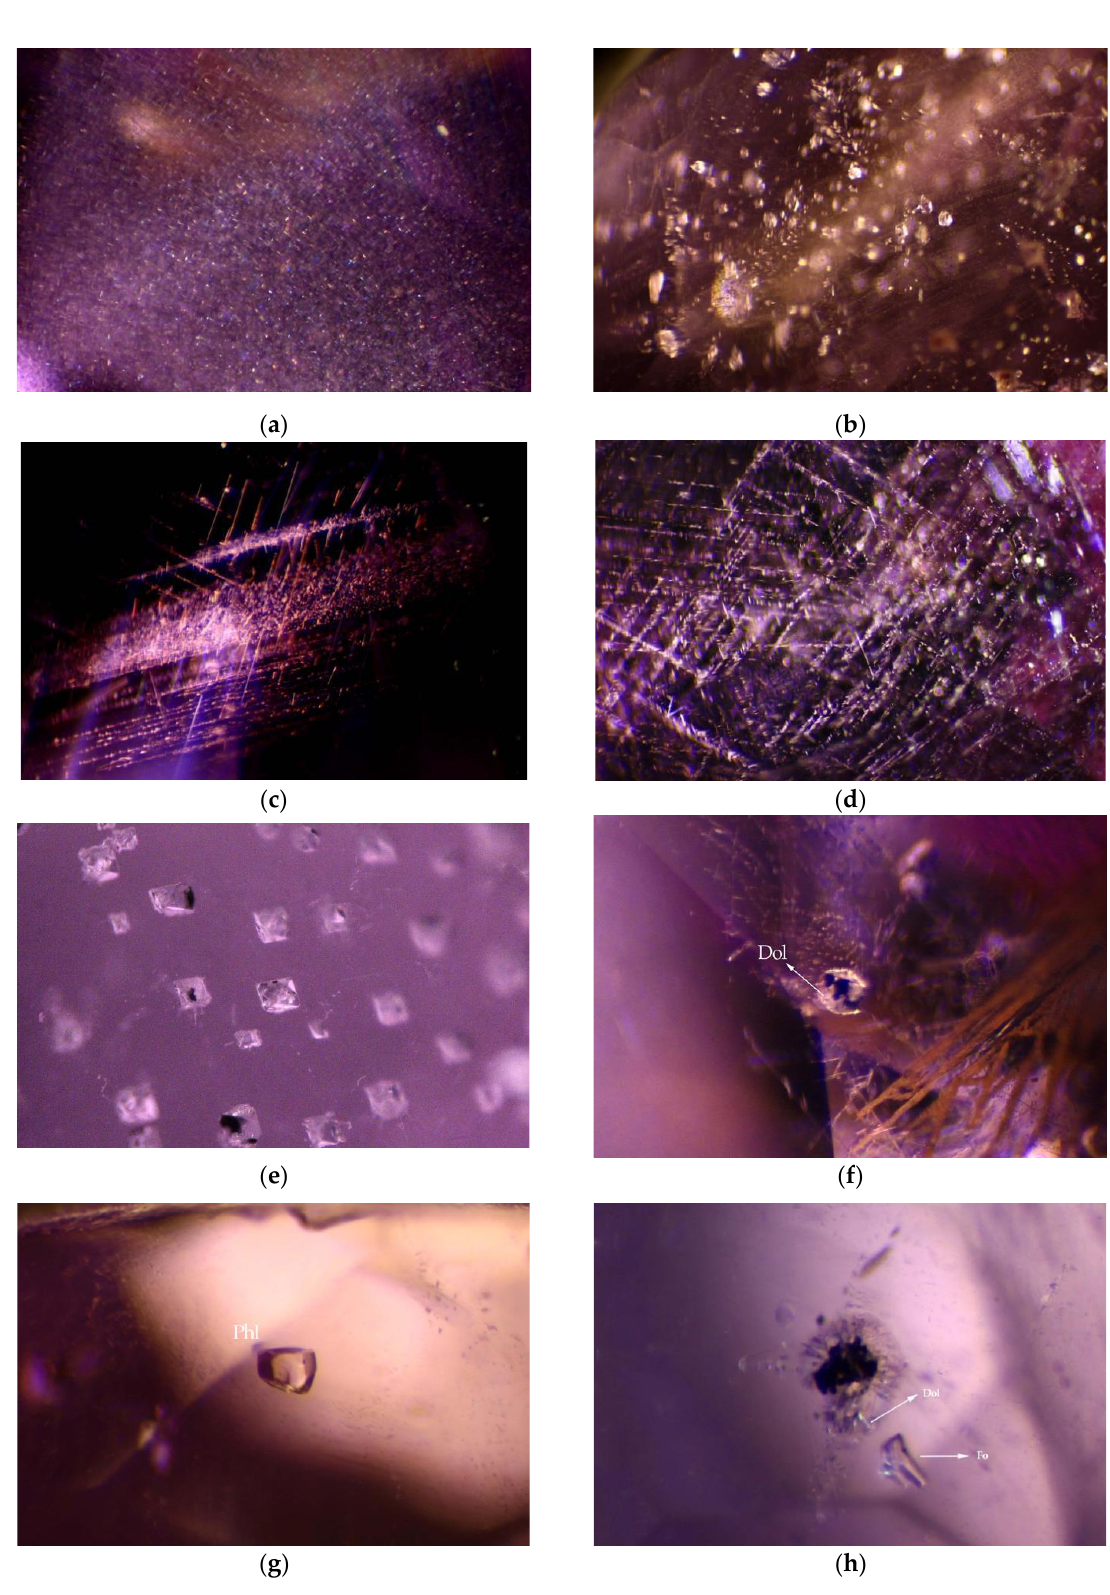
Figure 4. Inclusion scenes in purple spinels from Tanzania: ( a ) scattered tiny particles (40×); ( b ) negative crystals with fine particles (40×); ( c ) oriented, long iridescent needles (40×); ( d ) short nee- dles (40×); ( e ) dolomite aligned in a plane (600×); ( f ) a subhedral, whitish dolomite (Dol) in contact with black mineral (80×); ( g ) an isolated, colorless phlogopite (Phl) (80×); ( h ) a colorless, irregular dolomite (Dol), and a subhedral forsterite (Fo) (80×). Myanmar purple spinels in this study are relatively internally clean. Among the in- clusions seen in the Myanmar spinel were colorless mineral inclusions identified as apa- tite, magnesite, anhydrite, and pyroxene, irregularly shaped black graphite, and reddish- brownish baddeleyite. Apatite [Ca 5 (PO 4 ) 3 (F, Cl, OH)] inclusions are present in a variety of other habits ranging from substantially prismatic, subhedral to rounded (Figure 5a – c). Sometimes, they were accompanied by attached black irregular graphite. Magnesite ap- peared with a “frosted halo” around (Fi gure 5d), and a subhedral mineral belonging to the pyroxene supergroup shows a distinct set of cleavage planes (Figure 5e). A tiny color- less anhydrite [CaSO 4 ] was discovered (Figure 5f), which easily hydrates and then com- bines into gypsum. A reddish-brownish, prismatic baddeleyite [ZrO 2 ] with a tension crack is a surprise in this study (Figure 5g). To date, baddeleyite and anhydrite have only been discovered in Myanmar spinel [13]. Therefore, the combination of subhedral baddeleyite and anhydrite may indicate the locality of Myanmar. Raman spectroscopy allowed the identification of several mineral inclusions, and the representative Raman spectra are shown for these mineral inclusions analyzed in our sam- ples, together with a spectrum of the host spinel in Figure 6. ( a )